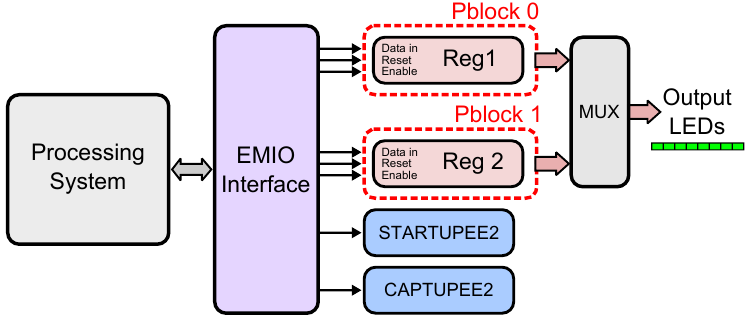
Figure 7. Block diagram of the validation